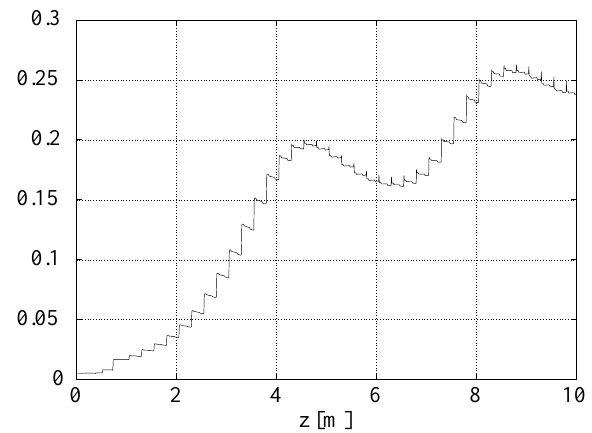
FIG. 9. Evolution of rms energy spread, normalized to the microbunch centroid energy.